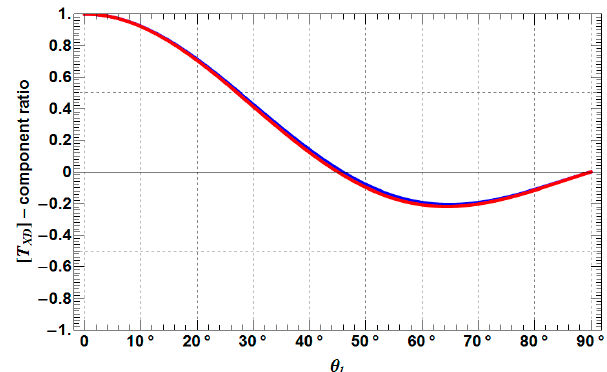
ω ϕ = 0°) and comparison with sinc (4 θ l = 30°,